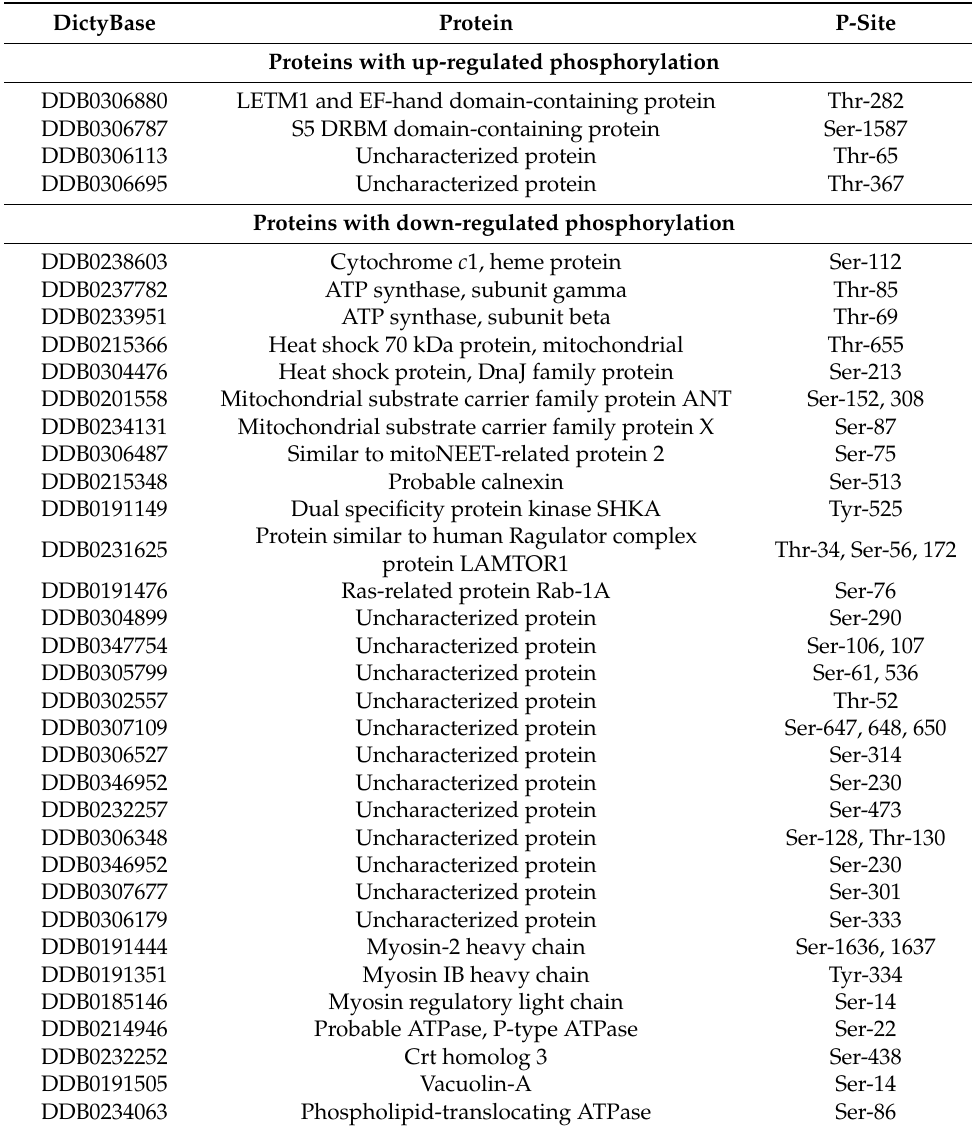
Table 3. Differentially phosphorylated proteins identified in mitochondrial preparations from the D. discoideum HPF444 strain in comparison to WT in at least two biological replicates or two peptides. P-site, phosphorylation site (number of phosphorylated amino acid residue within the identified peptide). Detailed quantitative analysis is presented in Table